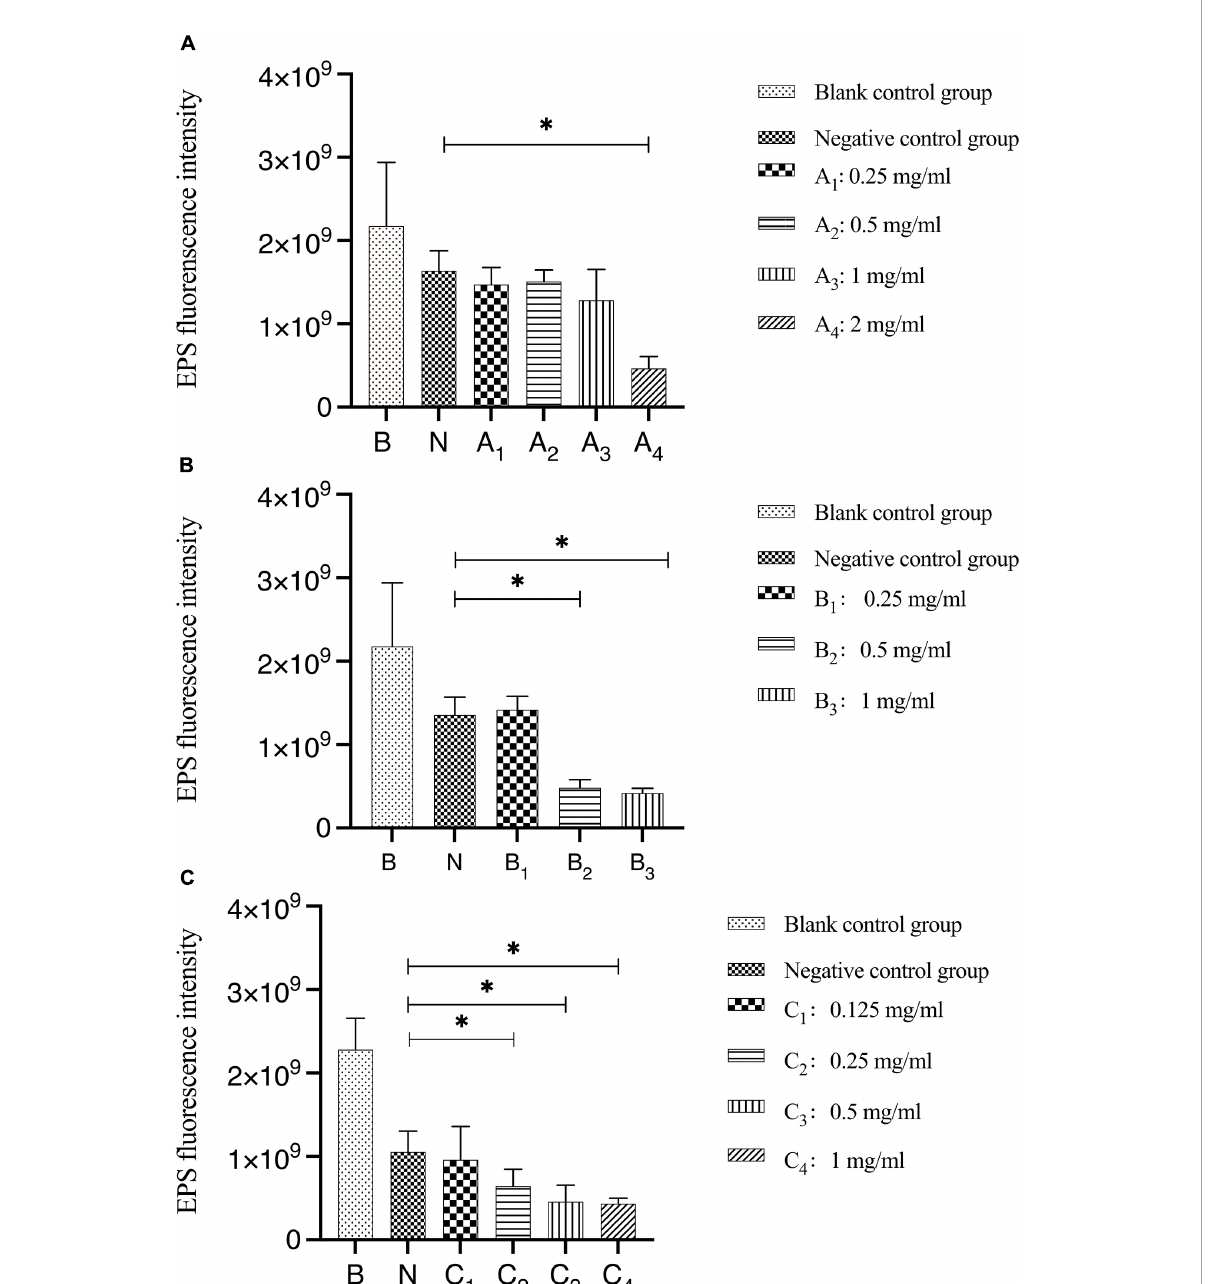
FIGURE4 Quantitative analysis of the total amount of EPS in biofilms after bovine trypsin treatment for 30 s, 1 min, and 3 min. (A–C) Are the quantitative analysis of the total amount of EPS in the biofilms after bovine trypsin treatment for 30 s, 1 min, and 3 min, respectively. ∗ Indicates that there is a statistically significant difference compared with the negative control group ( P <